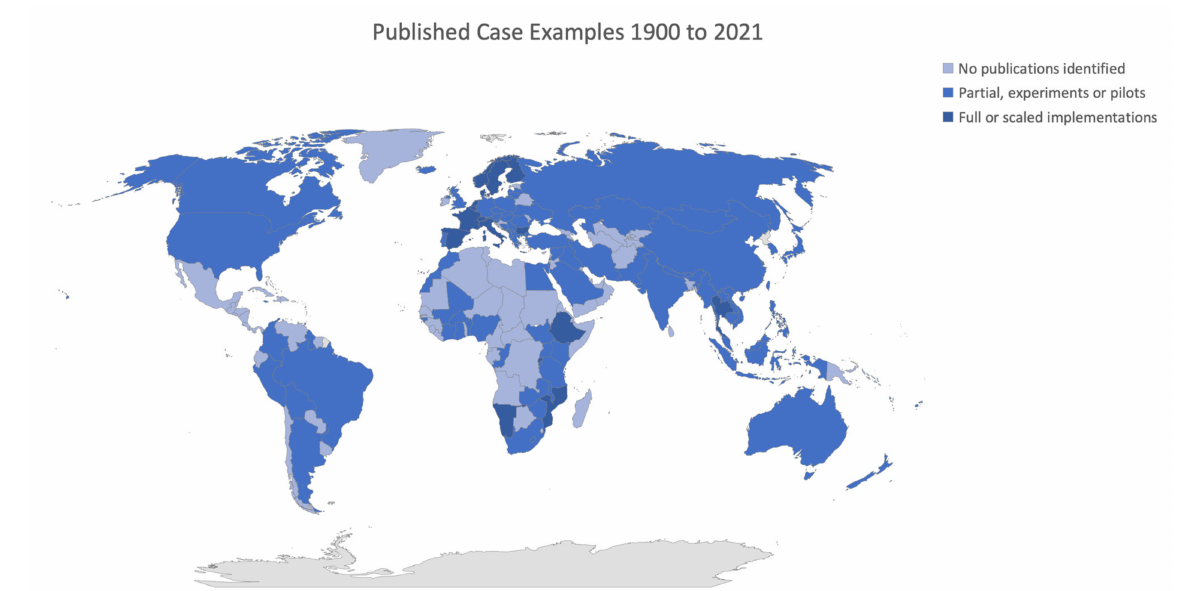
Figure 13. Remote sensing and photogrammetry applied to land administration: review results depicted